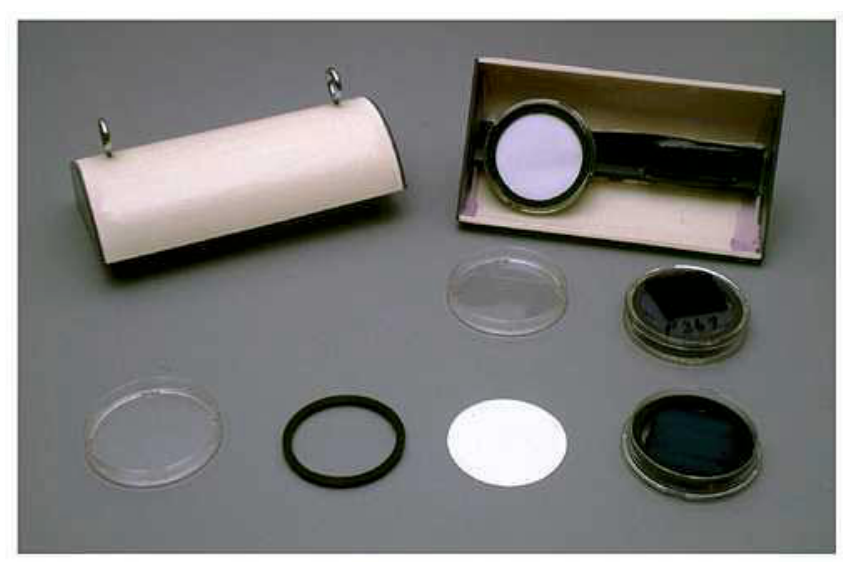
FIGURE 1. The CanOxy Plate passive ozone sampler showing the two plates which each have a clear lid and contain a support ring, blue (Indigo) reagent paper, separation ring which separates the paper and the Teflon diffusion membrane, and a retaining ring. The plate is exposed by removing the